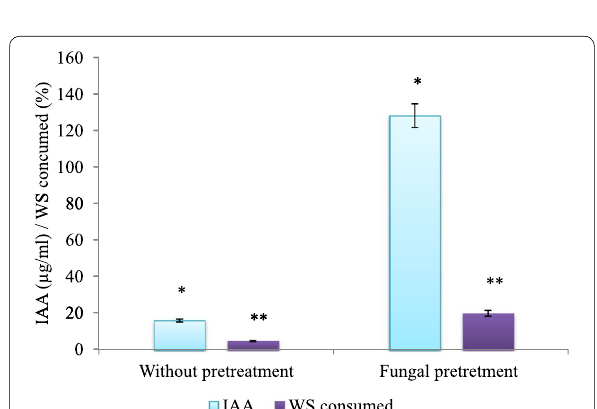
Fig. 2 Production of IAA (µg/ml) by P. fermentans and wheat straw (WS) consumed (% (w/w)) with and without fungal pretreatment after secondary fermentation (* or ** represents statistical significant difference ( P <